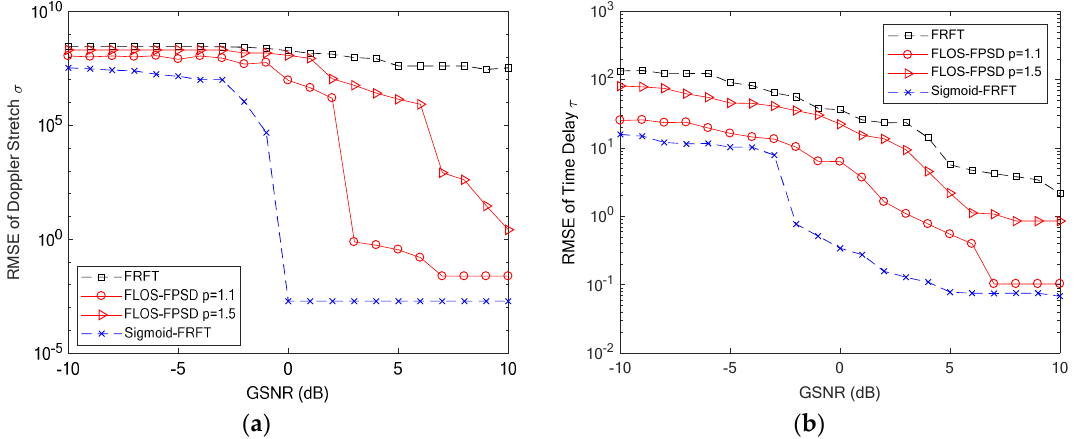
Figure 4. Root Mean Square Error (RMSE) of parameters versus GSNR. ( a ) Doppler stretch; ( b ) time delay.